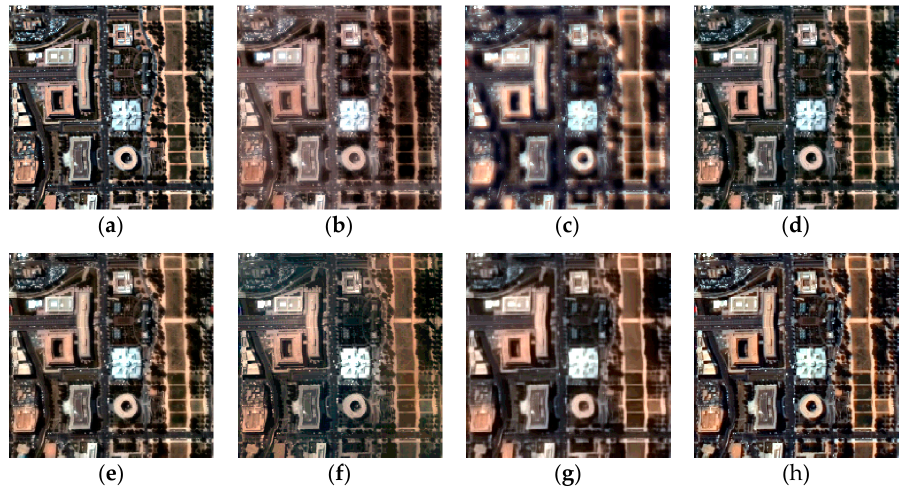
Figure 9. Visual comparison of different hyperspectral pansharpening methods for Washington DC dataset. ( a ) Reference; ( b ) PCA; ( c ) GFPCA; ( d ) HySure; ( e ) MGH; ( f ) CNMF; ( g ) Sparse Representation; ( h ) Proposed.